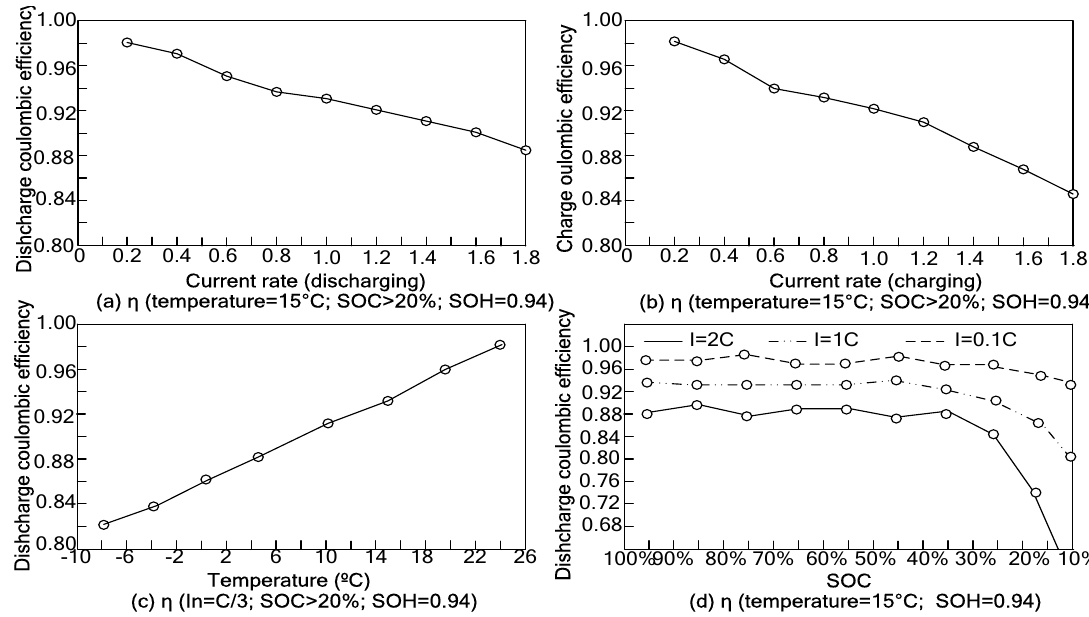
Figure 2. The influences of discharge/charge current, temperature and available capacity on Coulombic efficiency. ( a ) η (temperature = 15 °C, SoC > 20%, SoH = 0.94) for discharging; ( b ) η (temperature = 15 °C, SoC > 20%, SoH = 0.94) for charging; ( c ) η ( I n = C /3, SoC > 20%, SoH = 0.94); ( d ) η (temperature = 15 °C, SoH =